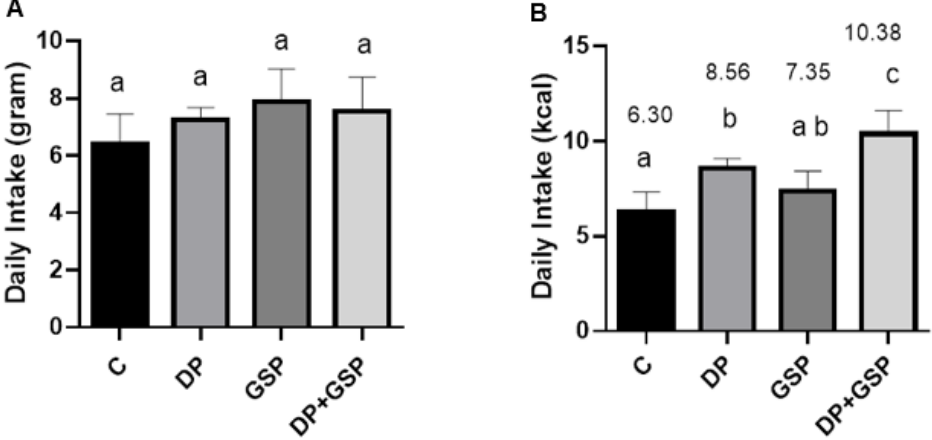
Figure 4. Average daily food consumption. Food consumption was measured every other day and compared between groups. Data bars with shared alphabetic symbols are not significantly different. Data are presented as mean +/ − SEM. ( A ) There was no difference in the mass of food consumed. ( B ) There were significant differences between the groups in the energy consumed. Note that the DP+GSP group consumed significantly more daily calories than any of the other groups. Note that the DP group consumed significantly more calories than the C